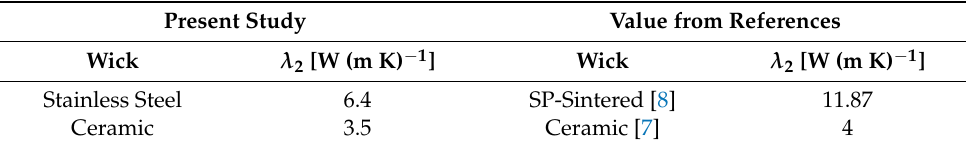
Table 5. Thermal conductivity of wicks.